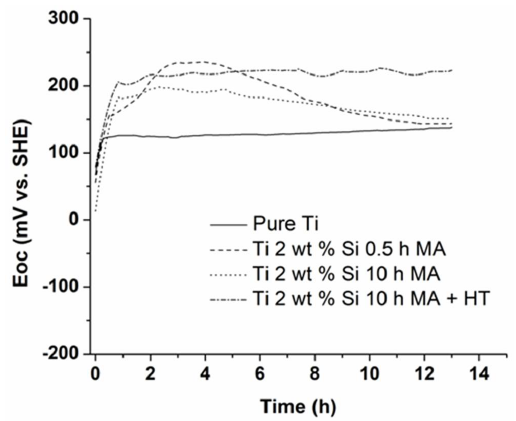
Figure 8. E OC measurements for pure Ti and Ti 2 wt %-Si alloys in 1.63 M H 2 SO 4 solution.